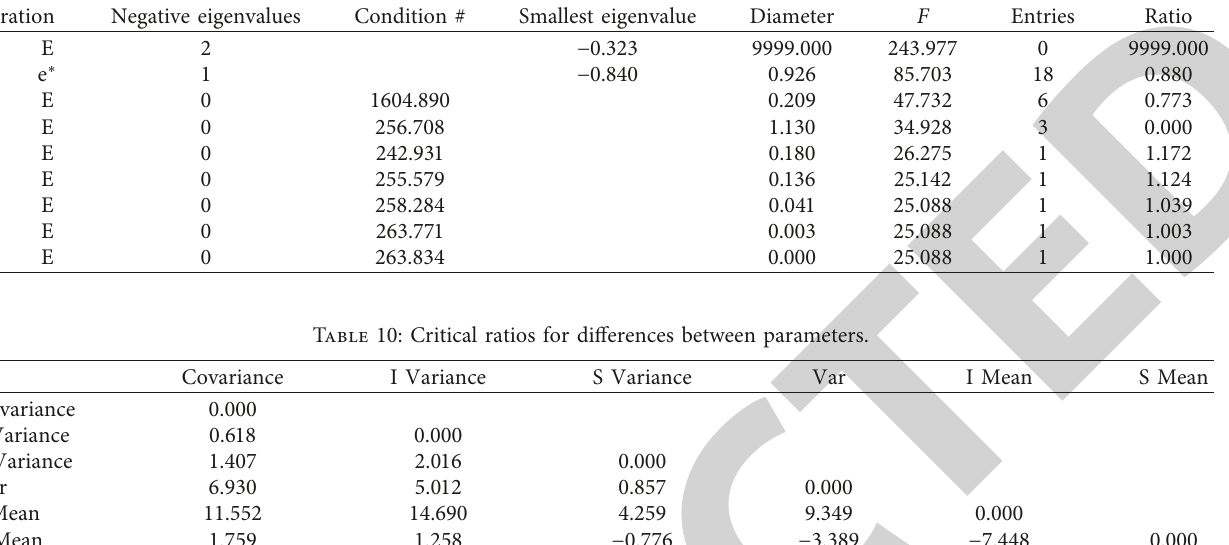
Table 9: Minimization